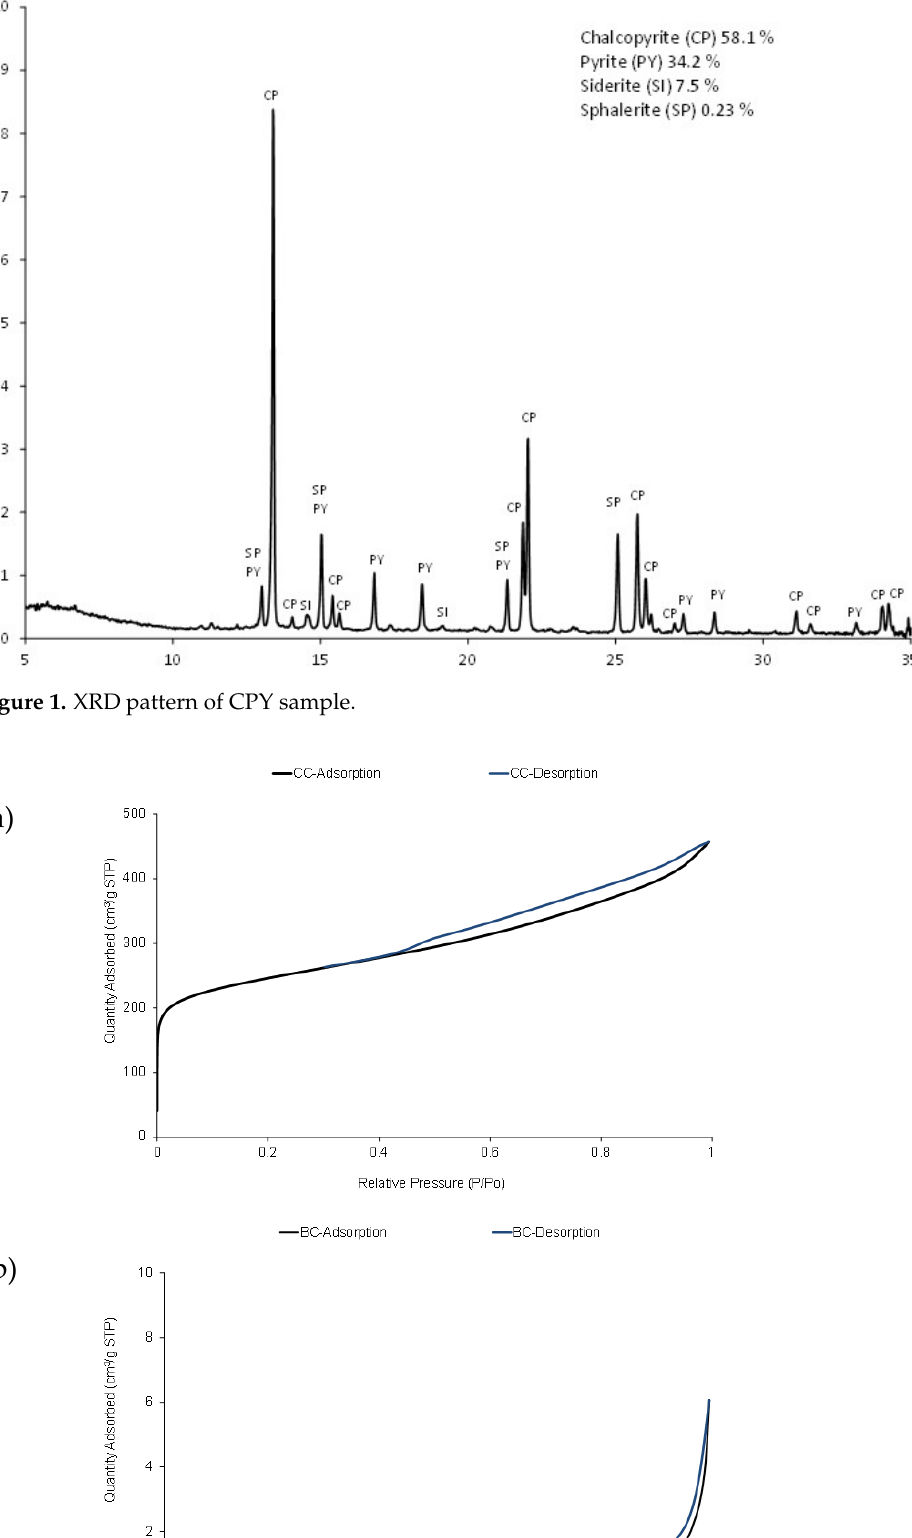
Figure 2. N 2 isotherms of ( a ) CC and ( b ) BC carbon materials .